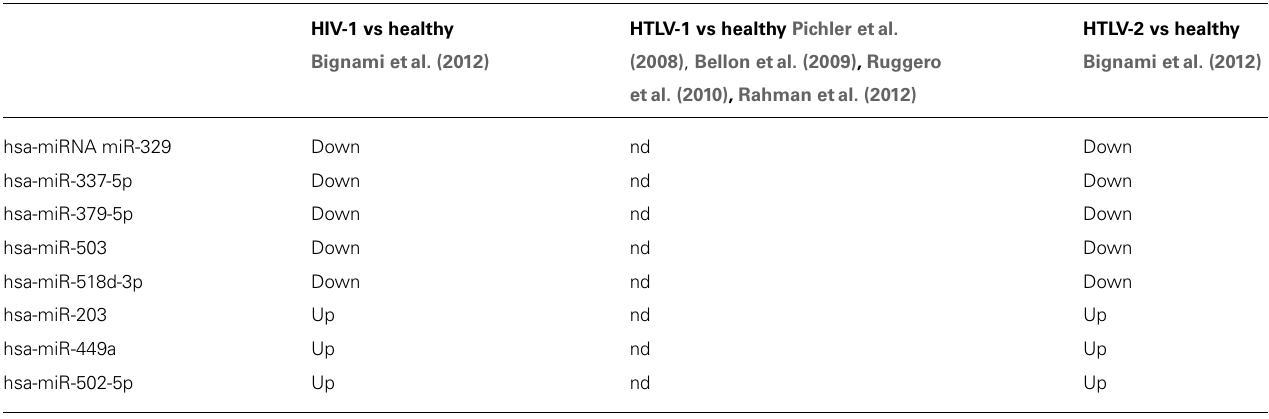
Table 1 | MicroRNAs equally expressed in HIV-1 and HTLV-2 vs HTLV-1 infection.